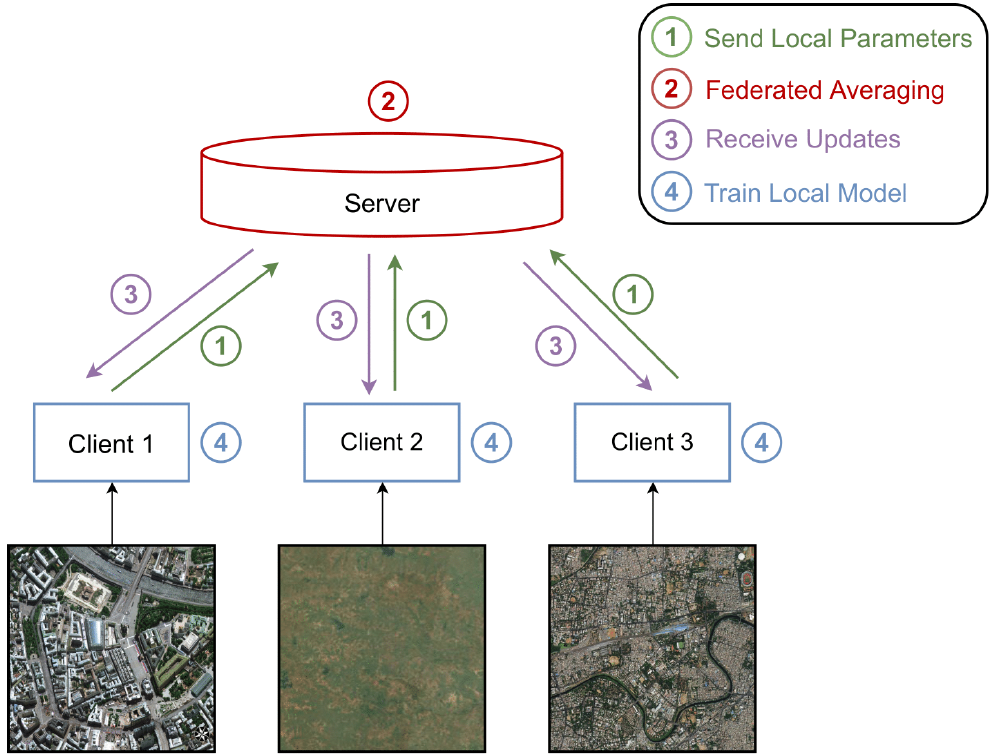
Figure 1. FL model for semantic segmentation of satellite